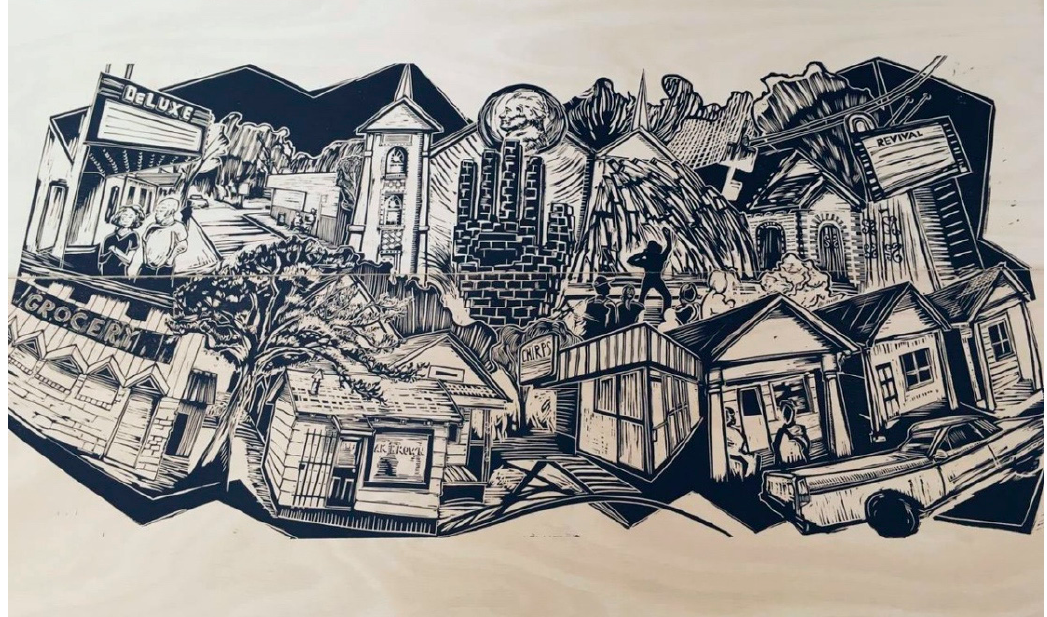
Figure 8. Siver Black’s print installation, “Nickel Views,” includes multiple hand drawn images of the Fifth Ward. Photograph by Emily Sloan, courtesy of Mystic Lyon.